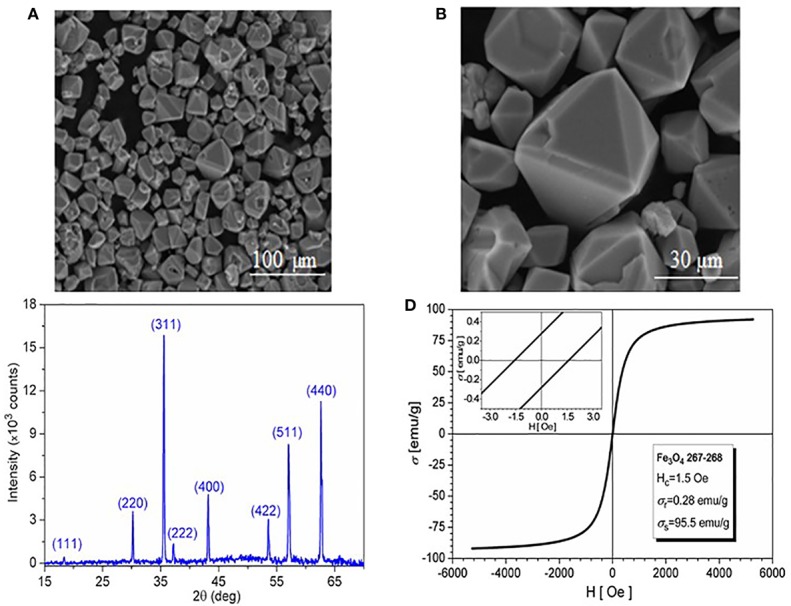
(A) SEM image of magnetite; (B) SEM image detail; (C) XRD spectrum; and (D) Hysteresis loop at room temperature.